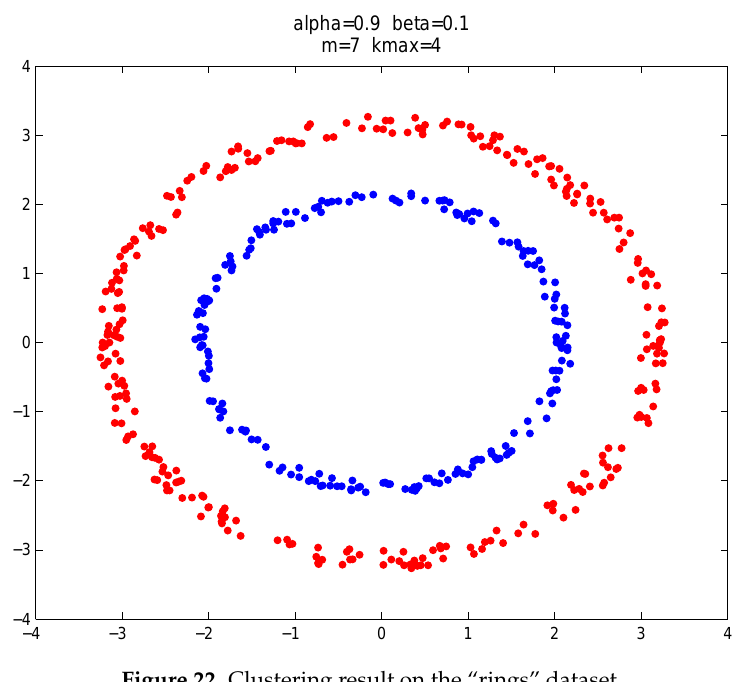
Figure 22. Clustering result on the “rings” dataset.